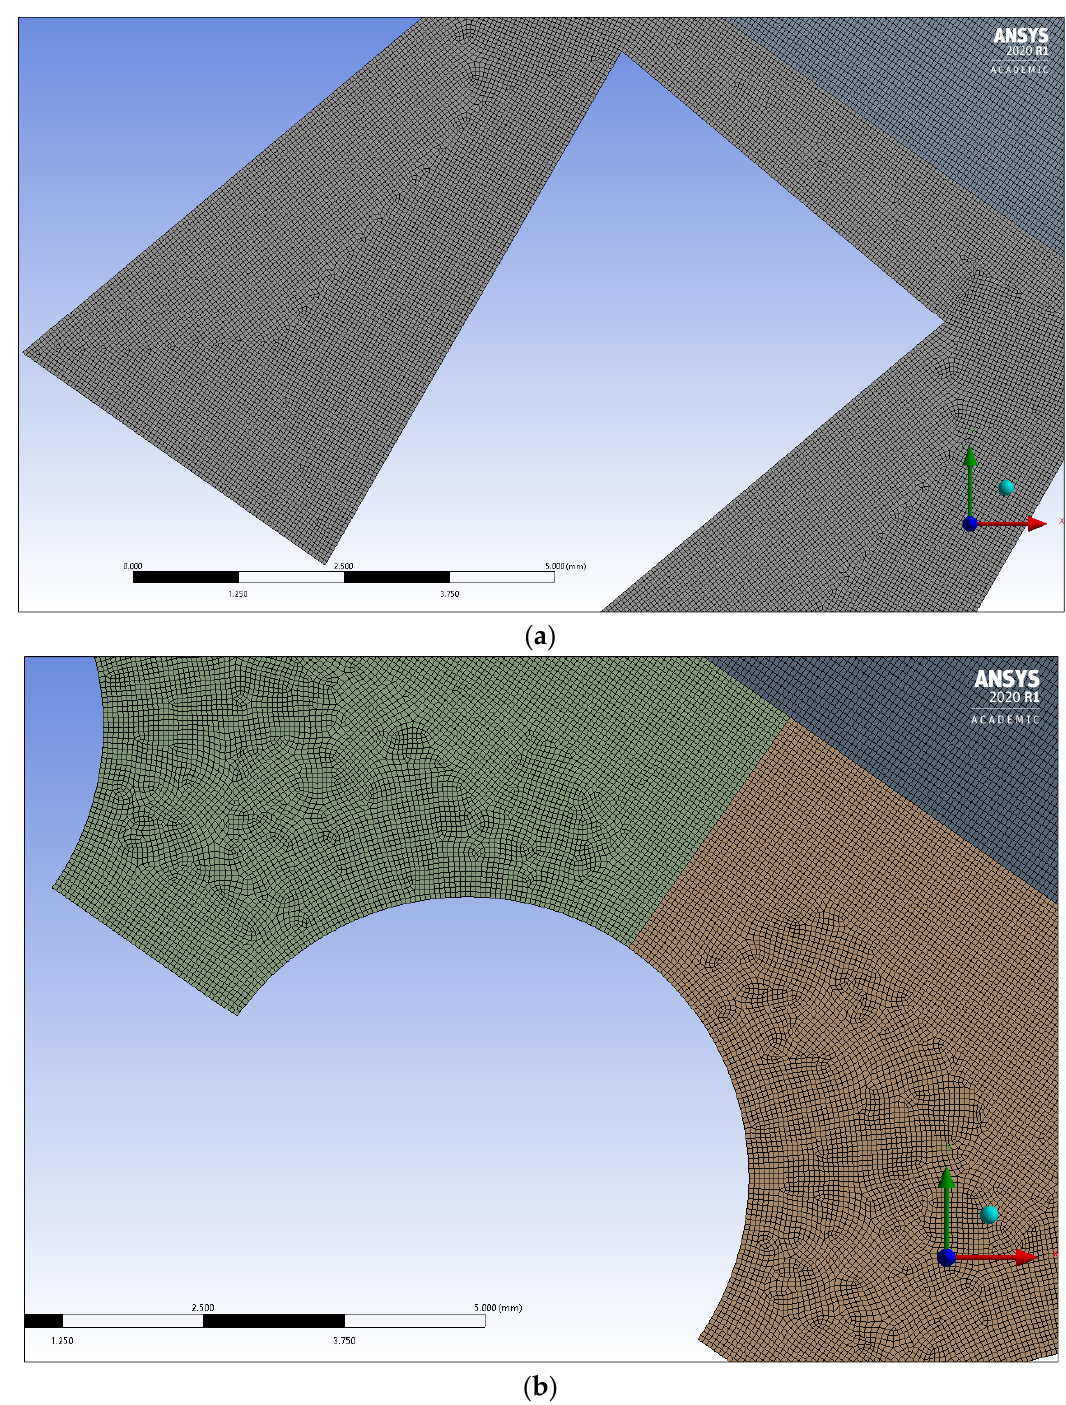
Figure 4. 2D tetrahedrical mesh in the computational domain: ( a ) triangular wire screen mesh; ( b ) circular wire screen mesh.